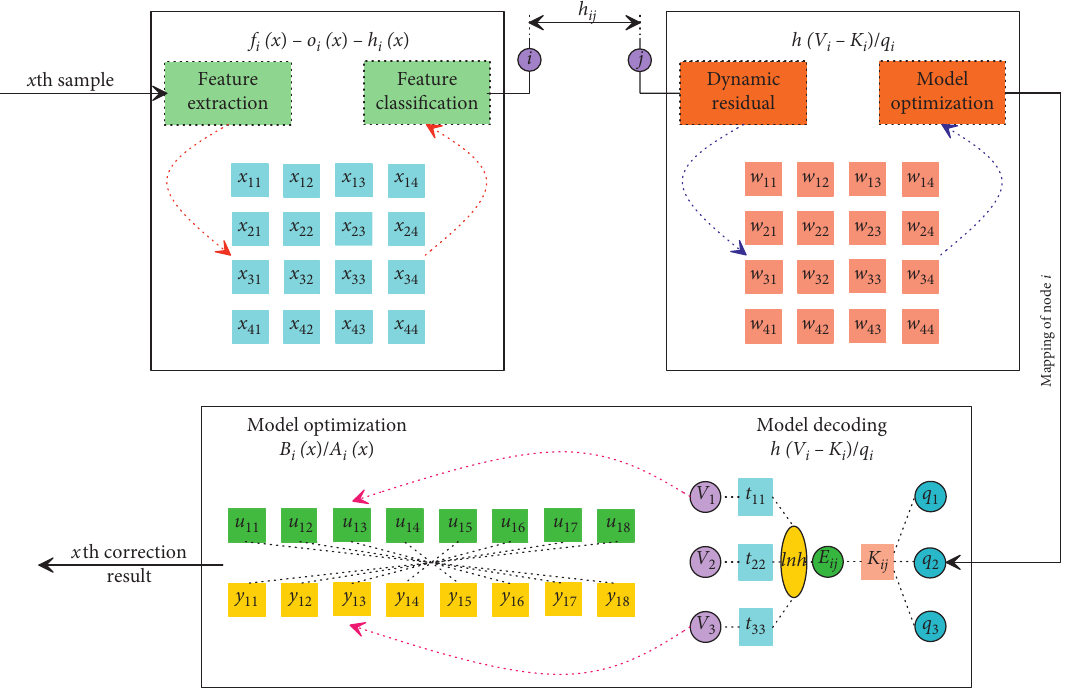
Figure 4: Algorithm processes of English grammar error correction based on classification